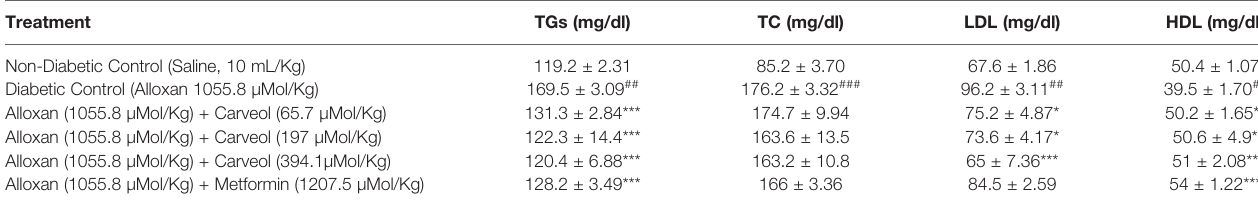
TABLE 5 | Effect of carveol on levels of triglycerides (TGs), total cholesterol (TC), low-density lipoprotein (LDL), and high-density lipoprotein (HDL) in alloxan-induced diabetic rats. Treatment Non-Diabetic Control (Saline, 10 mL/Kg)